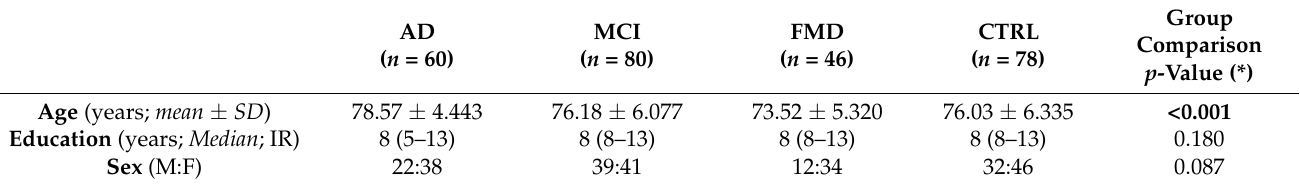
Table 1. Demographic characteristics of the